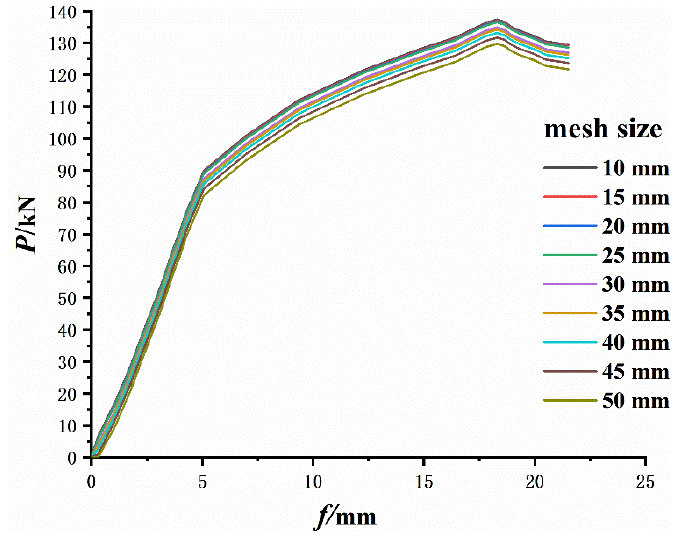
Figure 8. Load-deflection curve of different mesh